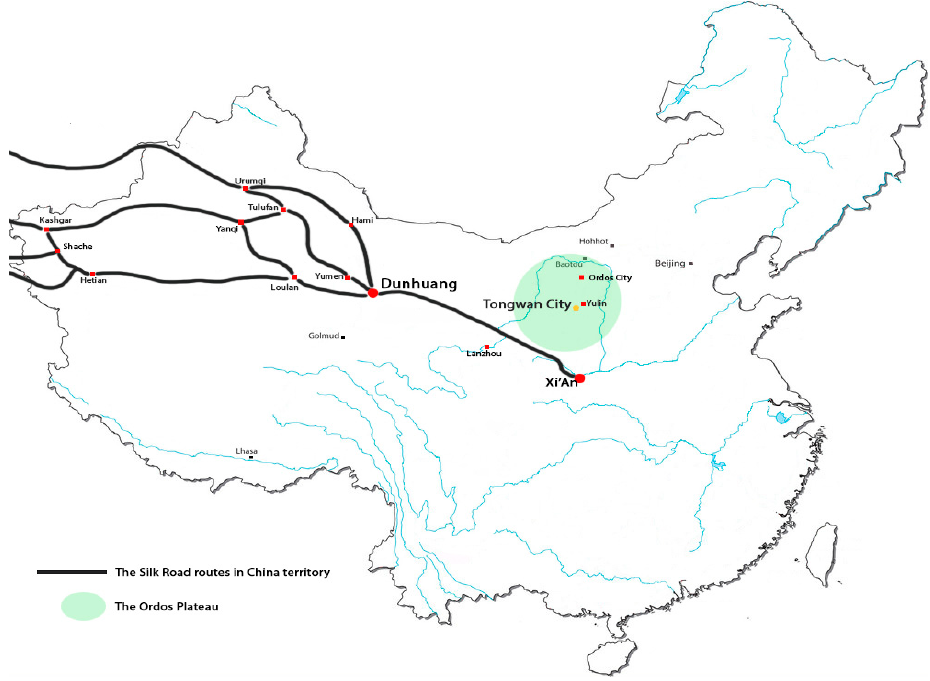
Figure 13. Tongwan City and the Ordos